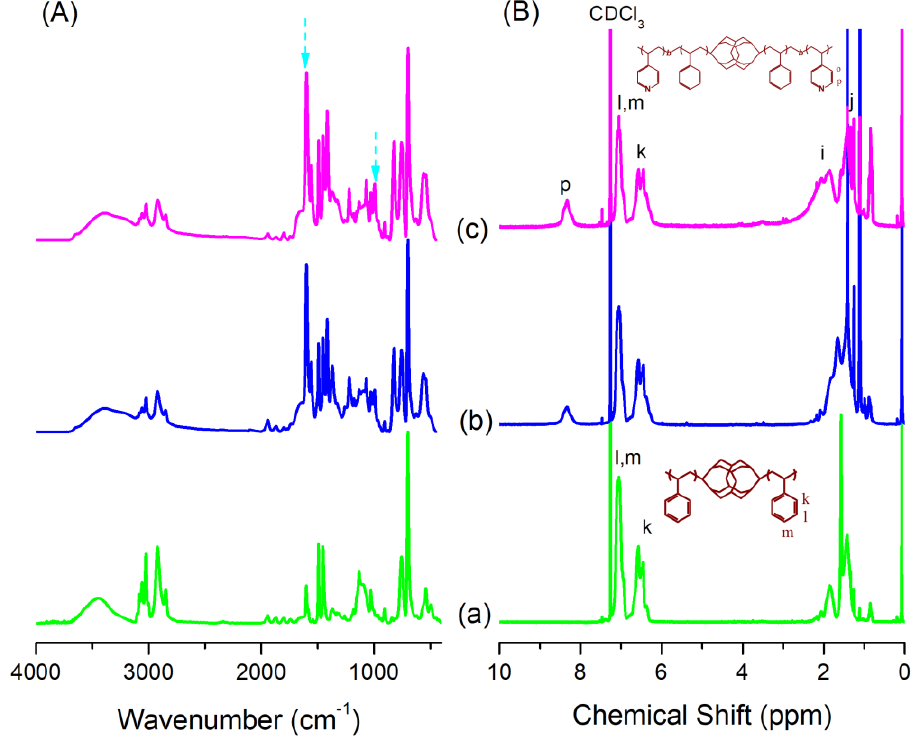
Figure8. ( A )FTIRand( B ) 1 HNMRspectraof( a )PS-DDSQ-PS,( b )P4VP 62 - b -PS 91 -DDSQ-PS 91 - b -P4VP 62 , Figure 8. ( A ) FTIR and ( B ) 1 H NMR spectra of ( a ) PS-DDSQ-PS, ( b ) P4VP 62 - b -PS 91 -DDSQ-PS 91 - b - and ( c ) P4VP 98 - b -PS 91 -DDSQ-PS 91 - b -P4VP 98 P4VP 62 , and ( c ) P4VP 98 - b -PS 91 -DDSQ-PS 91 - b -P4VP 98 .